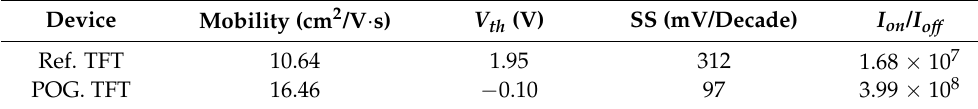
Table 1. Electrical parameters for InGaZnO TFT with/without SiN x surface plasma oxidation.